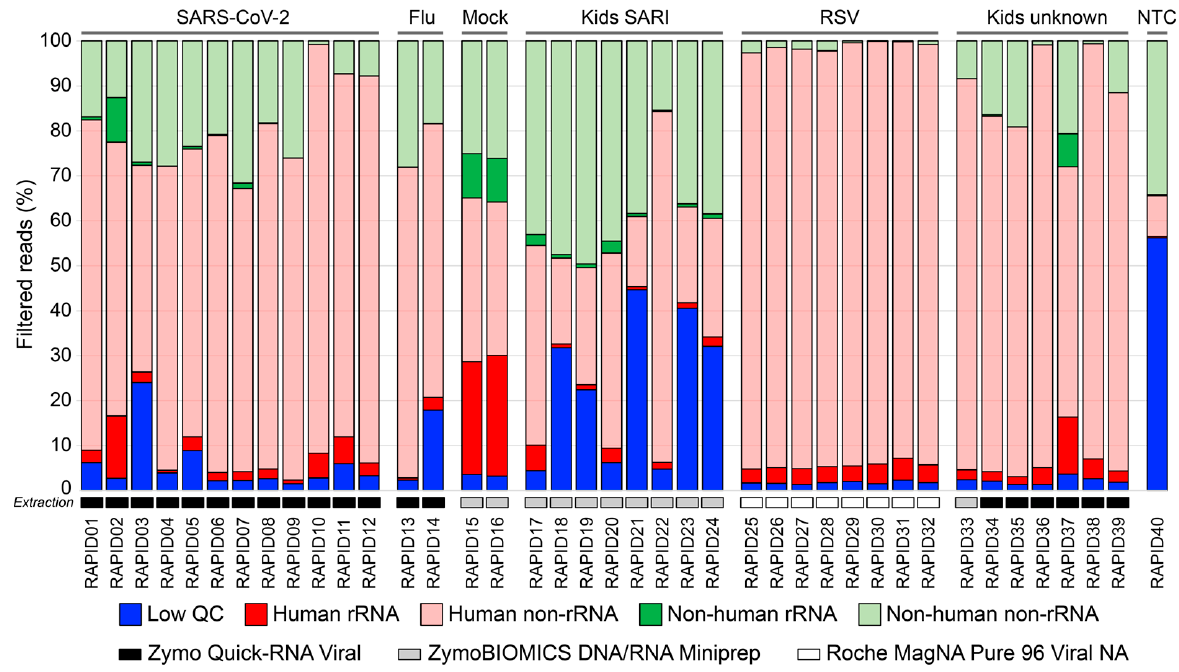
Figure 2. Filtered read distribution and classification across forty RAPID prep libraries. The sequence reads were classified into five categories: low-quality reads (blue), human rRNA reads (red), human non-rRNA (pink), non-human rRNA reads (green), and non-human non-rRNA reads (light green). Low-quality, human rRNA, human non-rRNA, and non-human rRNA were excluded from downstream analysis, and the non-human non-rRNA reads were the sole target reads for pathogen detection. Relative distribution was calculated by dividing the number of reads mapping to the relative category by the total number of reads for the individual library, before conversion into a percentage by multiplying the value by 100. The results were ordered by library number and grouped by sample type with a further key in grey shaded indicating the sample extraction platform used.